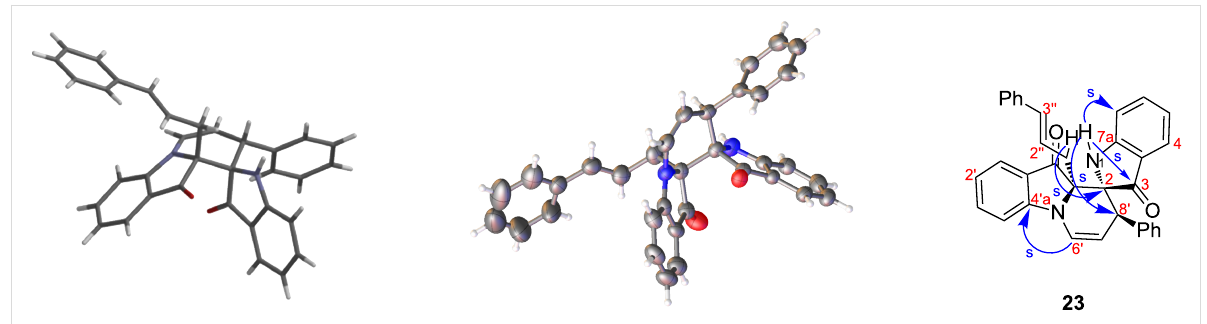
Figure 4: Structural analysis of compound 23 . Left: modelled structure showing the cisoid configuration of the NH and the cinnamyl substituents. Middle: X-ray crystal structure (ball and stick representation) showing the transoid NH/C8'-phenyl substituent disposition. Right: key HMBC correla- tions in support of the proposed structure (s = strong; w = weak). ORTEP data for 23 is given in Supporting Information File 1.